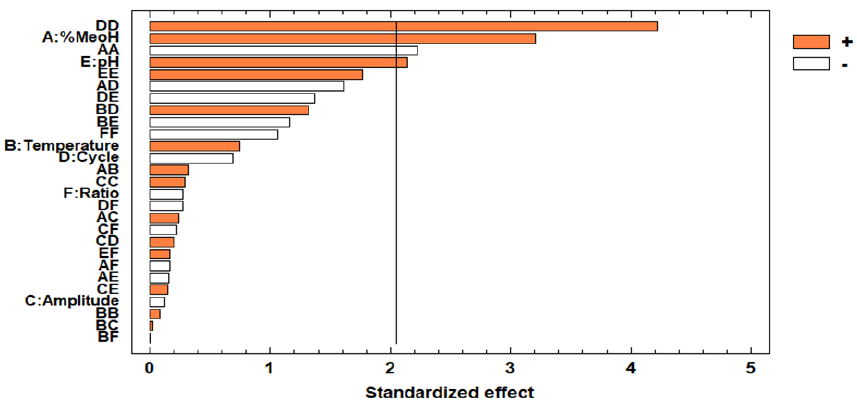
Figure 3. Pareto chart of the total phenolic compounds.